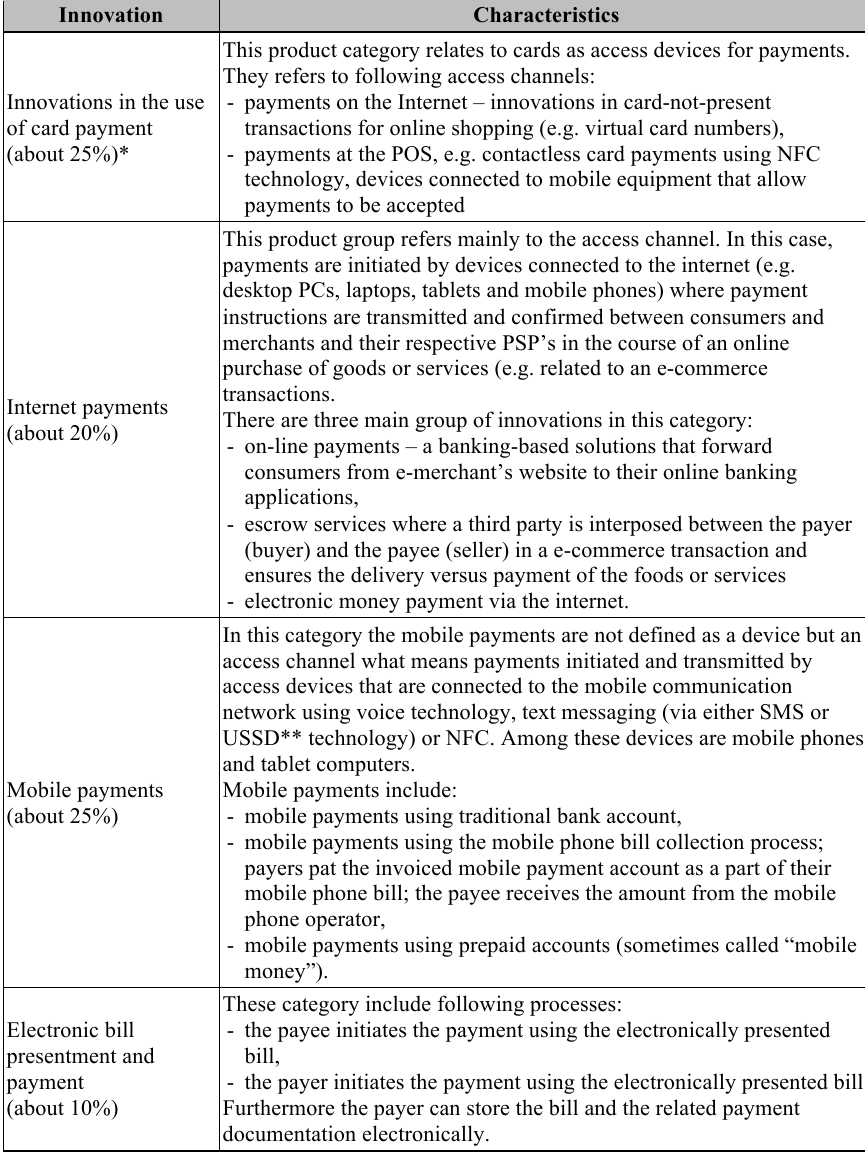
Table 2 The classification of retail payment product